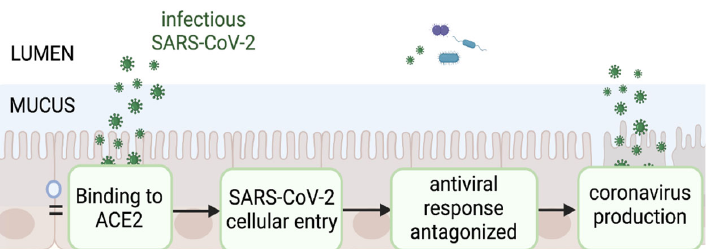
Figure 1. Pathway depicting the proposed sequence of events of a productive SARS ‐ CoV ‐ 2 infection in the gut. Virus binding to the ACE2 receptor expressed on enterocytes mediates viral entry inducing an antiviral response that must be antagonized for new virions to be produced. This manuscript will evaluate available published data on the likelihood of their occurrence.